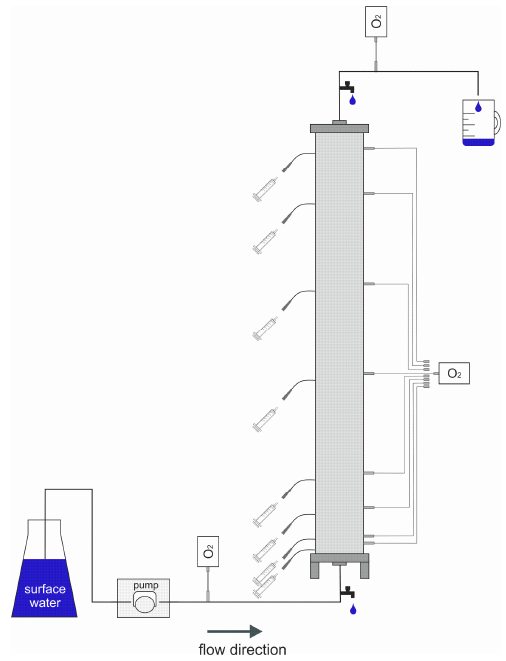
Figure 1. Experimental setup—adapted from Burke et al. [14].